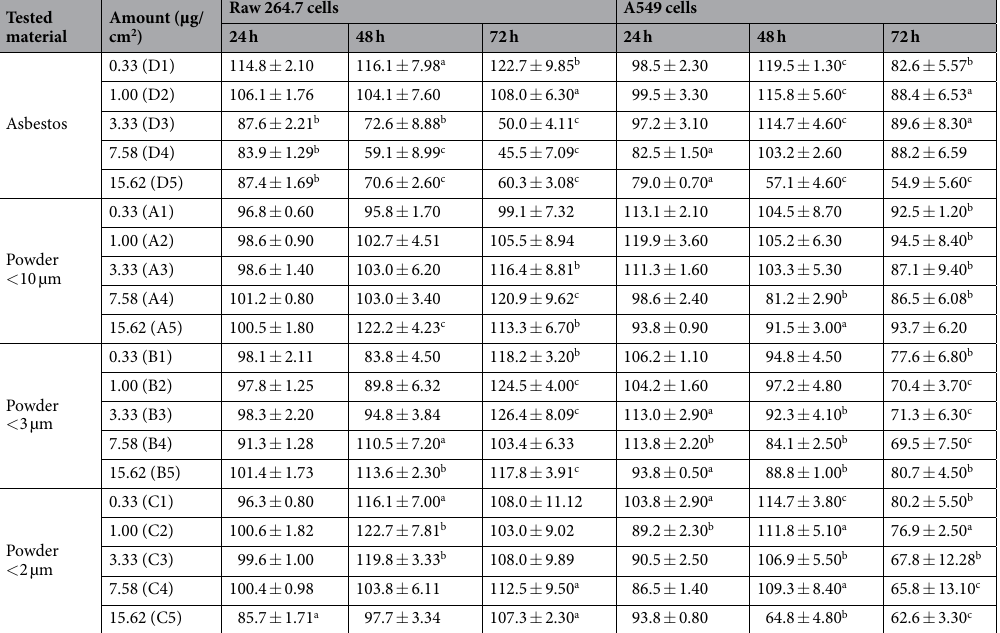
Table 2. Viability of A549 cells and Raw 264.7 cells exposed for varying time periods either to asbestos or to SHS-treated slags of different granulometry (see Fig. 2). The results are means ± SD of 8 replicates and are expressed as % of viability as compared with untreated controls of the corresponding cell lines. Statistical analysis: a P < 0.05, b P < 0.01, and c P < 0.001, as compared with untreated